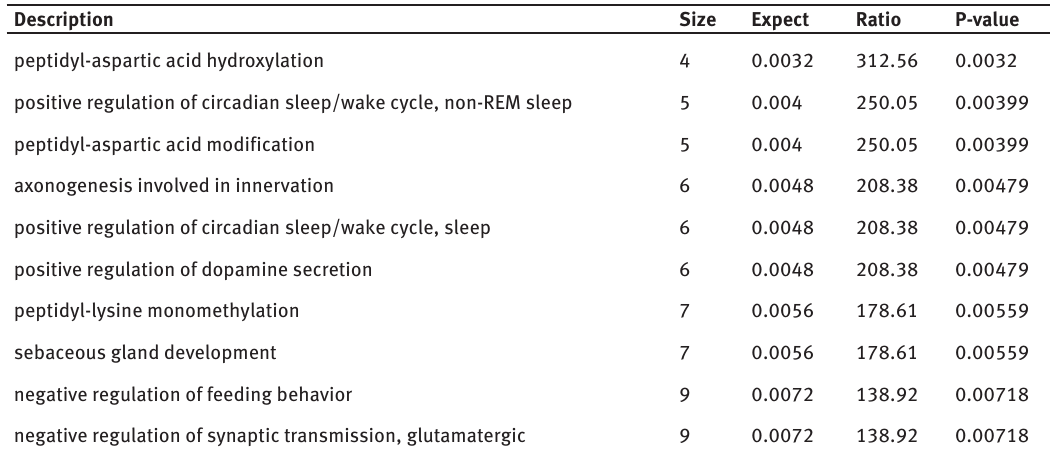
Table 1: Biological process enrichment for iNOS/NOS2 and co-expressed genes.